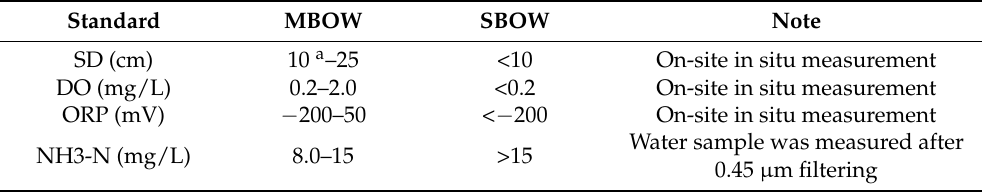
Table 1. Distinguishing standard and index determination method of urban BOW.